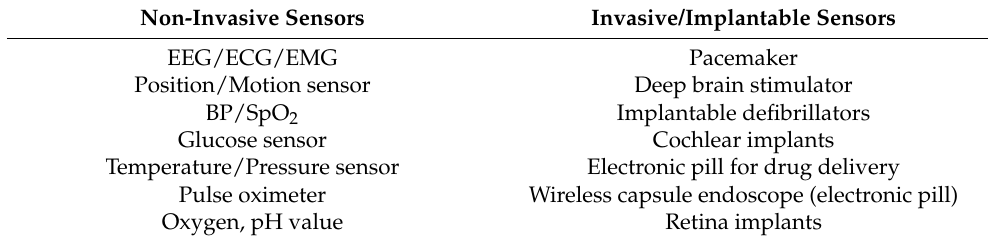
Table 5. Non-invasive and invasive sensors.